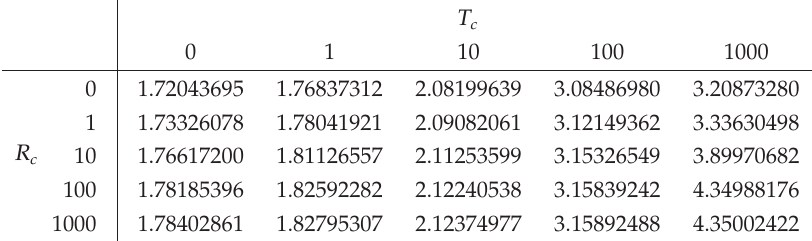
Table 5.2 . Values of coe ffi cients λ the intermediate point elastically restrained against rotation and